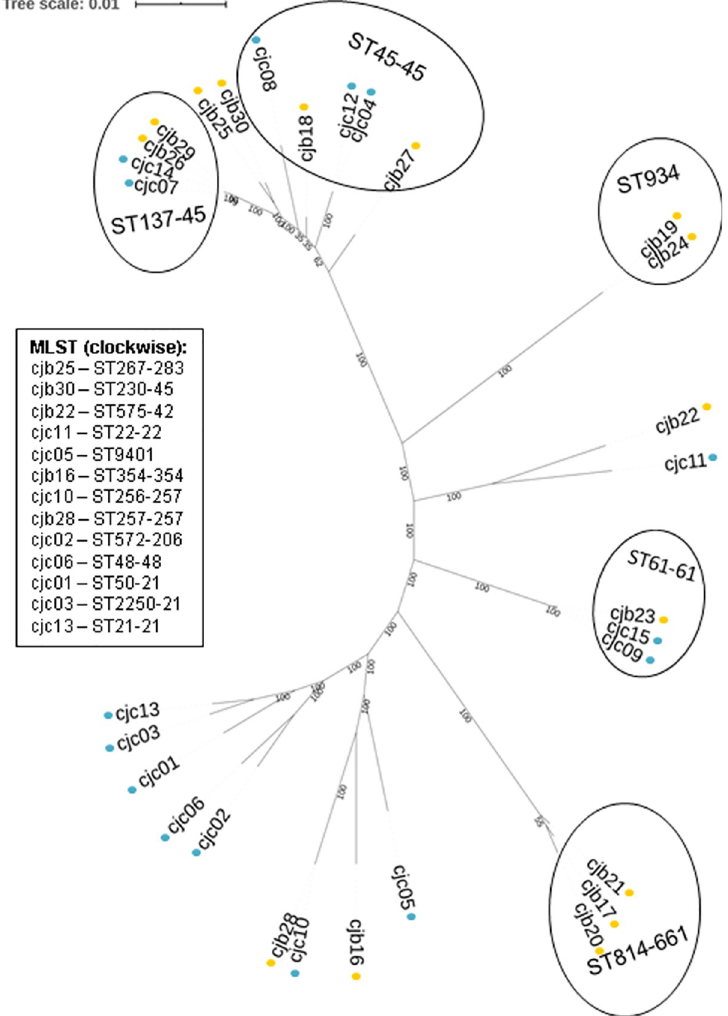
Fig 1. Maximum likelihood tree of C . jejuni isolates from clinical and broiler sources with bootstrap values depicted at the nodes Isolates CJC01—CJC15 were recovered from clinical human infection (blue dots), and CJB16—CJB30 were recovered from broilers (orange